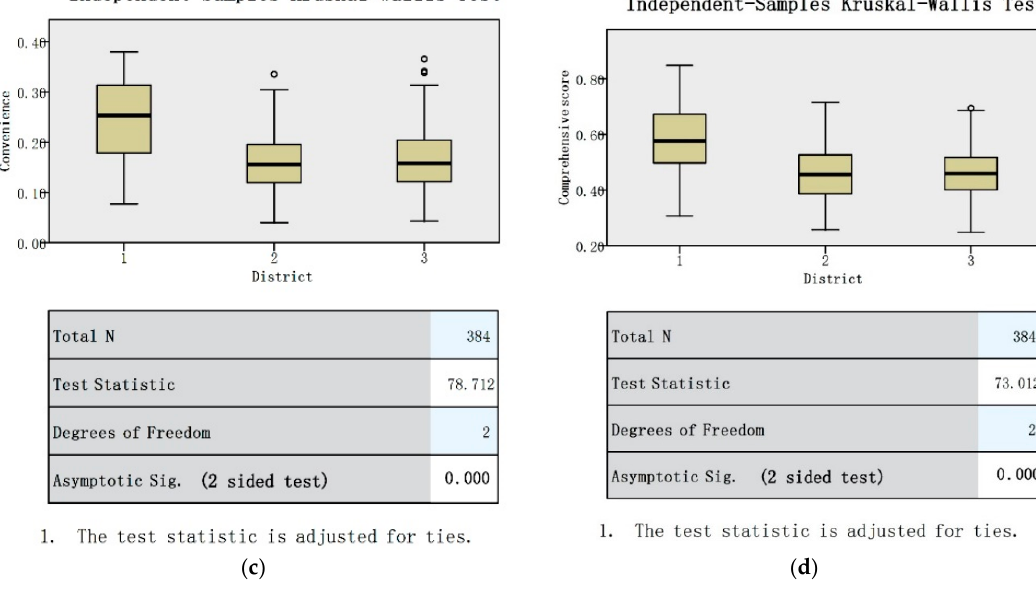
Figure 5. Kruskal–Wallis independent sample test boxplots of three categories scores including ( a ) supply and demand score results; ( b ) quality score results; ( c ) convenience score results; ( d ) comprehensive score results.